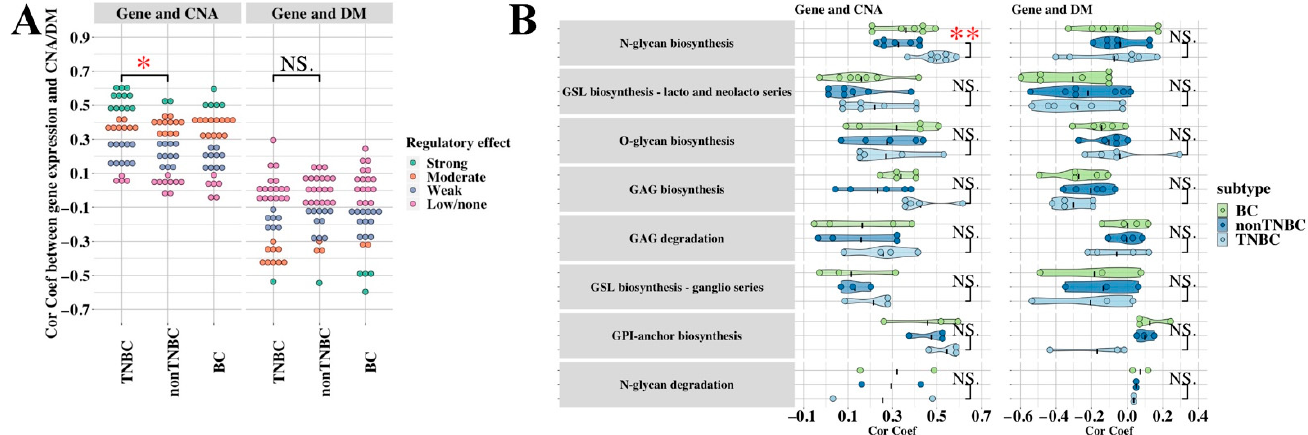
Figure 7. The influence of CNA and DM on candidate glycogene expression in TNBC and non-TNBC. TCGA dataset for gene expression, CNA and DM were analysed for correlation between CNA/DM and gene expression for the 34 candidate glycogenes. Spearman correlation coefficients are shown for all BCs, or divided into TNBC and non-TNBC groups and compared using the Wilcoxon test, at glycogene level ( A ), or grouped into glycosylation pathways ( B ). * p < 0.05; ** p < 0.001; NS, not significant. GAG, Glycosaminoglycan; GSL, Glycosphingolipid; GPI, Glycosylphosphatidylinositol.